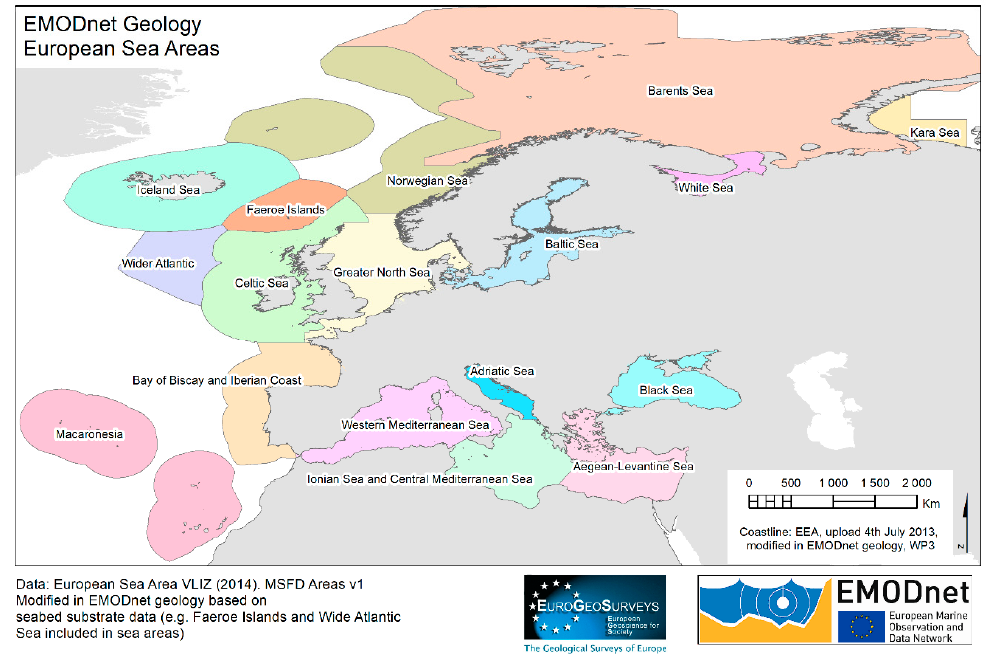
Figure 1. The European sea regions covered in the EMODnet Geology project.